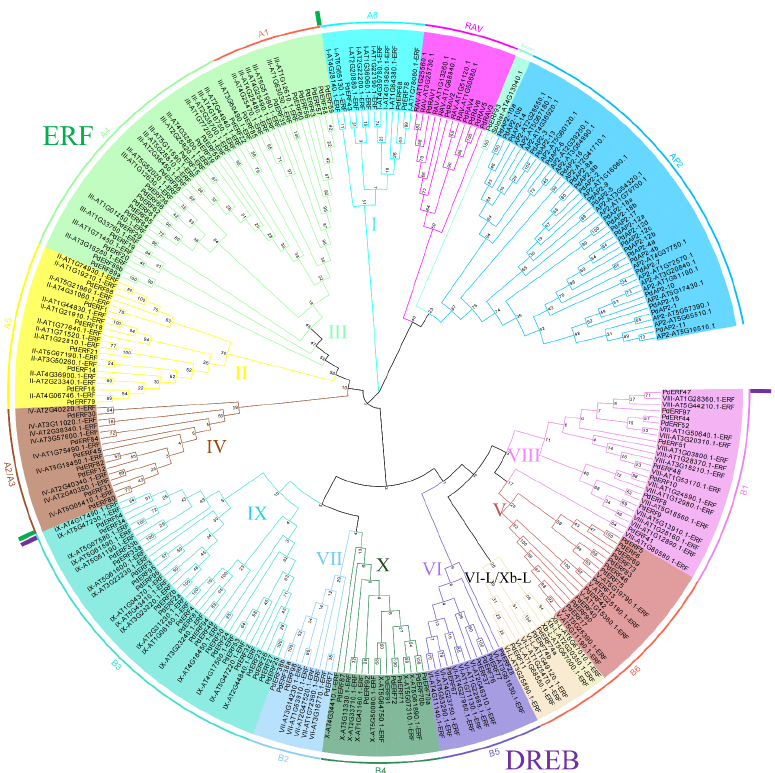
Figure 1. Phylogenetic tree of AP2/ERF family members in almond and Arabidopsis . Each color block represents a group. The area between the two green segments represents the ERF subgroup; the area between two purple segments represents DREB subgroup.